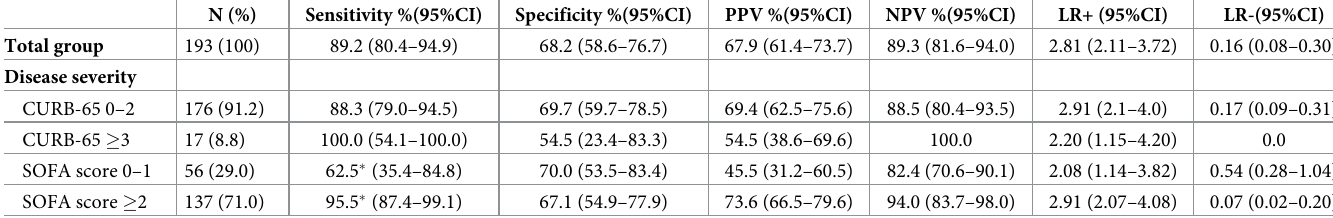
Table 3. Diagnostic accuracy of Chest CT for diagnosing COVID-19 in all patients and in relation to disease severity. N